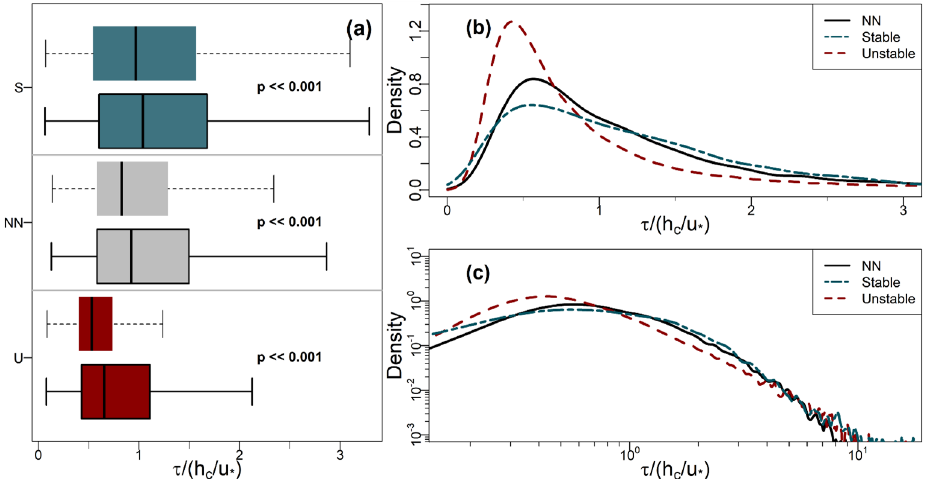
Figure 7. Statistics of normalised residence times (Sect. 2.3) binned by the stability classes defined in Sect. 2.6. (a) Box–whisker plots of normalised residence times for stable (S), near-neutral (NN), and unstable (U) conditions. Boxes with dashed whiskers and no border show leaf-off values; boxes with solid whiskers and borders show leaf-on (see Sect. 2.2 for observation details). Solid vertical lines indicate median values. Width of the boxes shows the IQR. Lower and upper whiskers, respectively, indicate the 25th percentile − 15 × IQR and 75th percentile + 15 × IQR. (b, c) PDFs of residence times for the leaf-on period, plotted on linear and logarithmic axes (base 10),